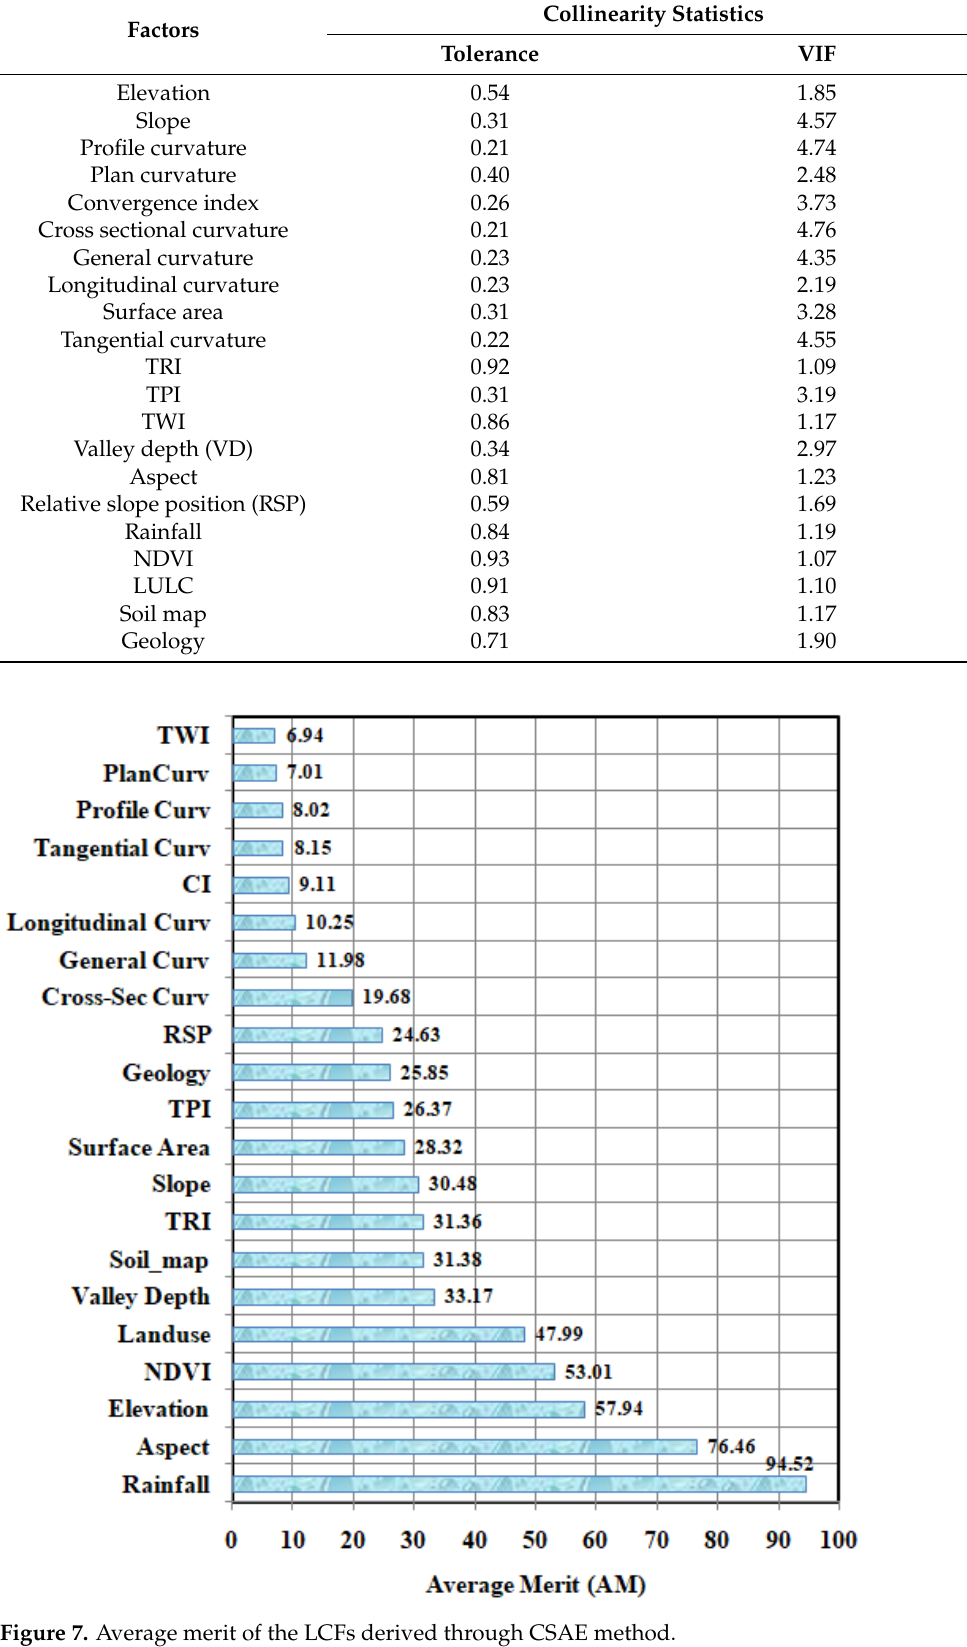
Figure 7. Average merit of the LCFs derived through CSAE